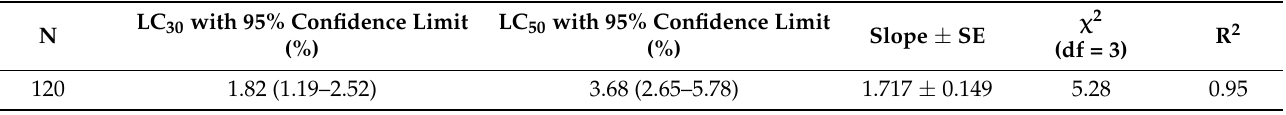
Table 1. Results of PPA digestive toxicity against the adults of Sitophilus oryzae . LC 30 with 95% Confidence Limit N